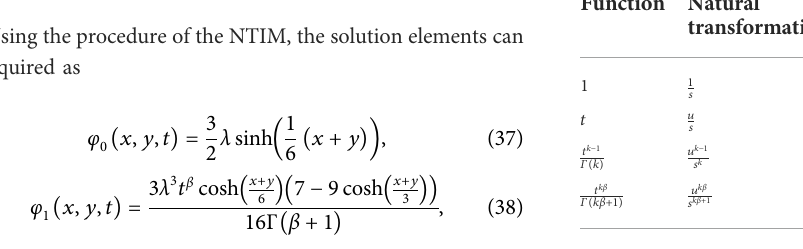
TABLE 1 Few important expressions and their natural transubstantiates . Function Natural Function Natural transformation